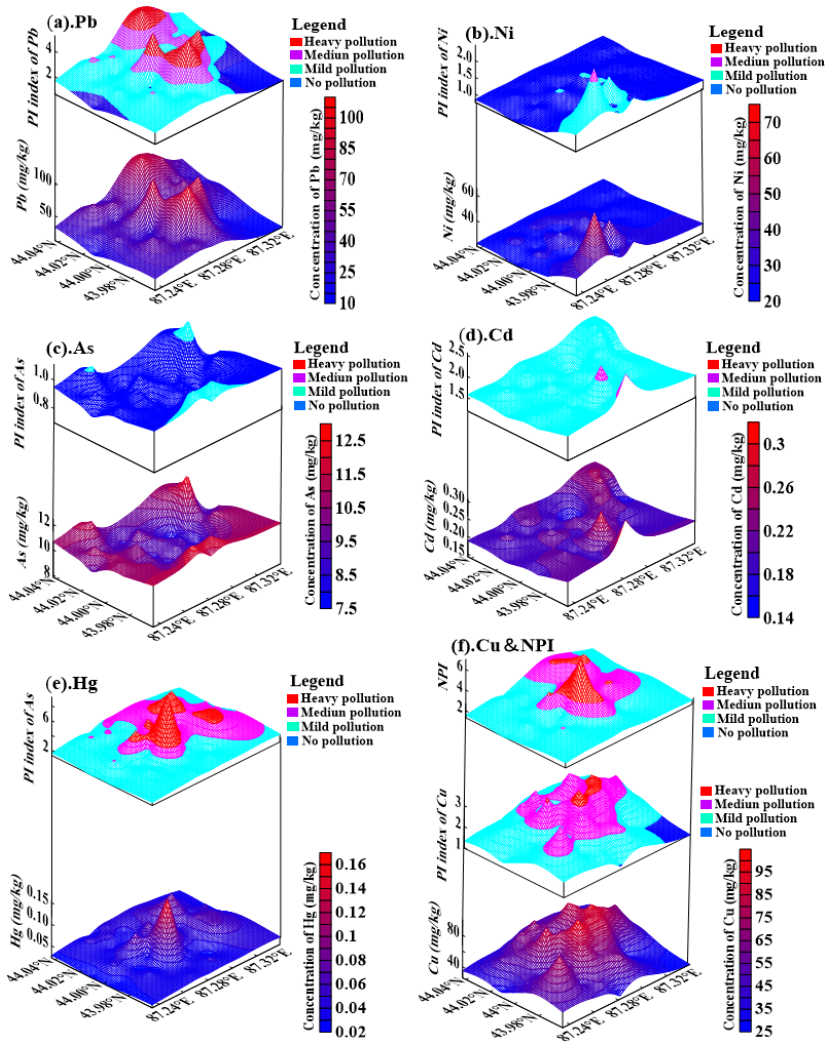
Figure 4. Spatial distributions of metal concentration and pollution